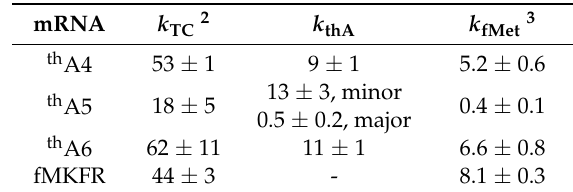
Table 1. Apparent rate constants (s − 1 ) for reactions between 70SICs programmed with th A-containing mRNAs and TC (0.4 µ M) 1 .